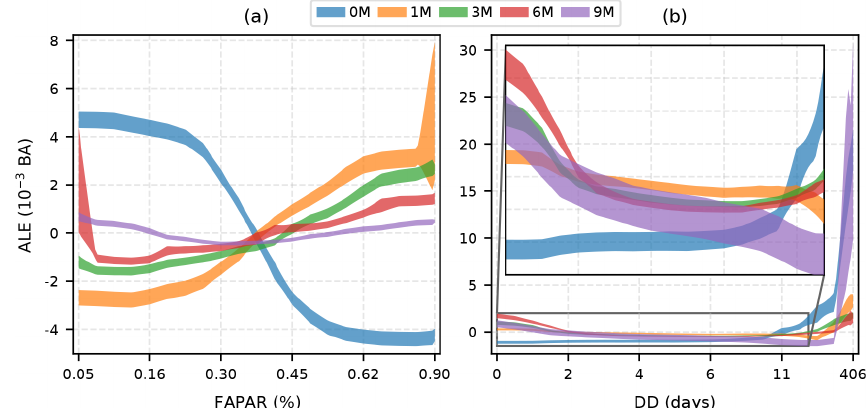
Figure 4. First-order ALEs for different antecedent (0M, 1M, 3M, 6M, and 9M, where M denotes months) relationships with (a) FAPAR and (b) DD in the 15VEG_FAPAR model, showing the underlying relationships with BA after accounting for all other variables. The shaded regions represent the standard deviation around the mean of 100 ALEs each using 122567 random samples of the training data ( ∼ 10%). Evenly spaced quantiles were used in the construction of the plots. Labels were calculated using the averaged quantiles of all the variables used. A clear difference between instantaneous and antecedent relationships can be seen in both cases, with instantaneous FAPAR limiting BA while antecedent FAPAR promotes BA, and vice versa for the dry-day period. Note that the enhancement of BA due to extreme droughts (extreme dry-day period) is apparent across time